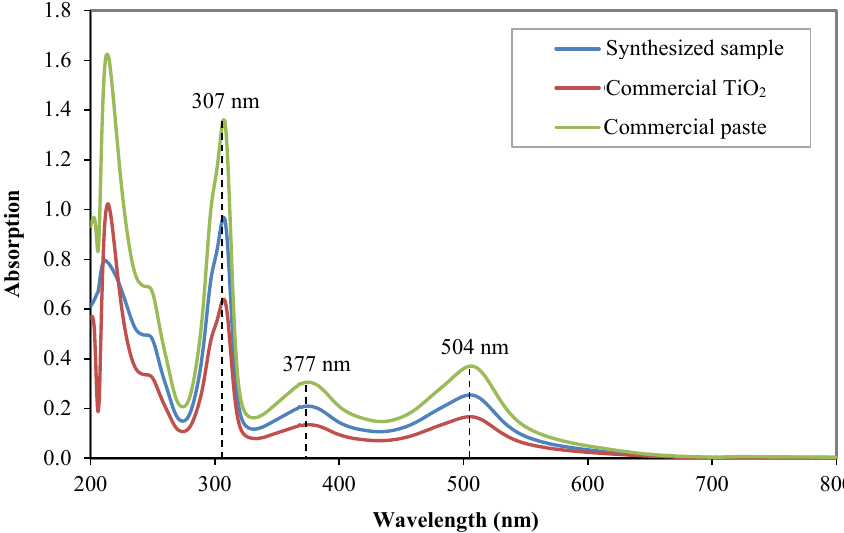
Figure 8. UV-Vis absorption spectra of desorbed dye solution of the synthesized sample, the commercial TiO 2 and the commercial paste.